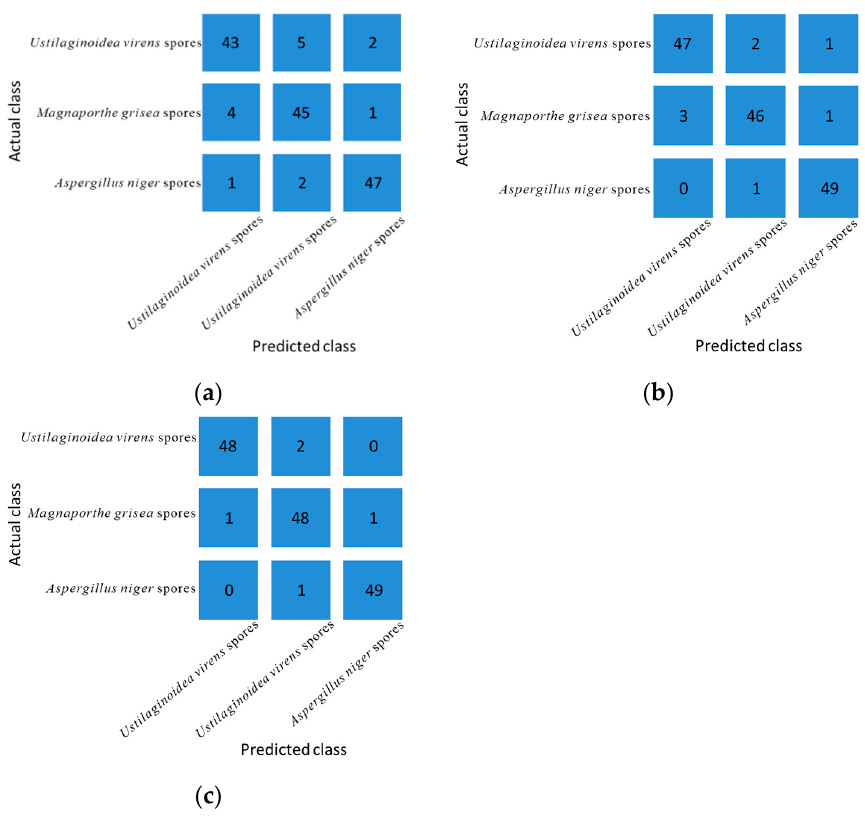
Figure 11. Confusion matrix for different classification models ( a ) KNN classification model confusion matrix ( b ) RF classification model confusion matrix ( c ) SVM classification model confusion matrix. Table 1. Classification results of different classification models.